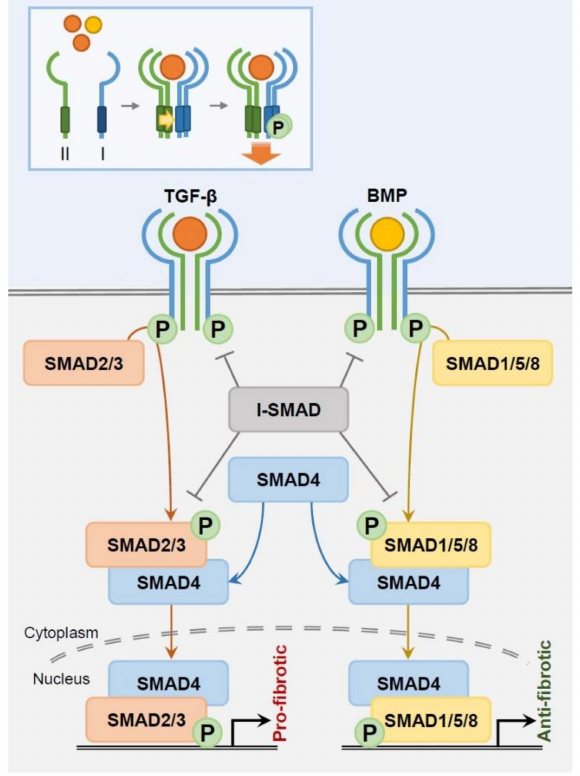
Figure 1. Schematic image of TGF- β / SMAD and BMP / SMAD signaling pathway in fibrosis (upper left box, signal activation via TGF- β receptor and ligand attachment; orange and yellow circles / arrows, TGF- β ligands / signaling and BMP ligands / signaling, respectively). Abbreviations: TGF- β , transforming growth factor beta; BMP, bone morphogenetic protein; P, phosphorylation; I-SMAD, inhibitory SMAD; I, TGF β R1; II, TGF β